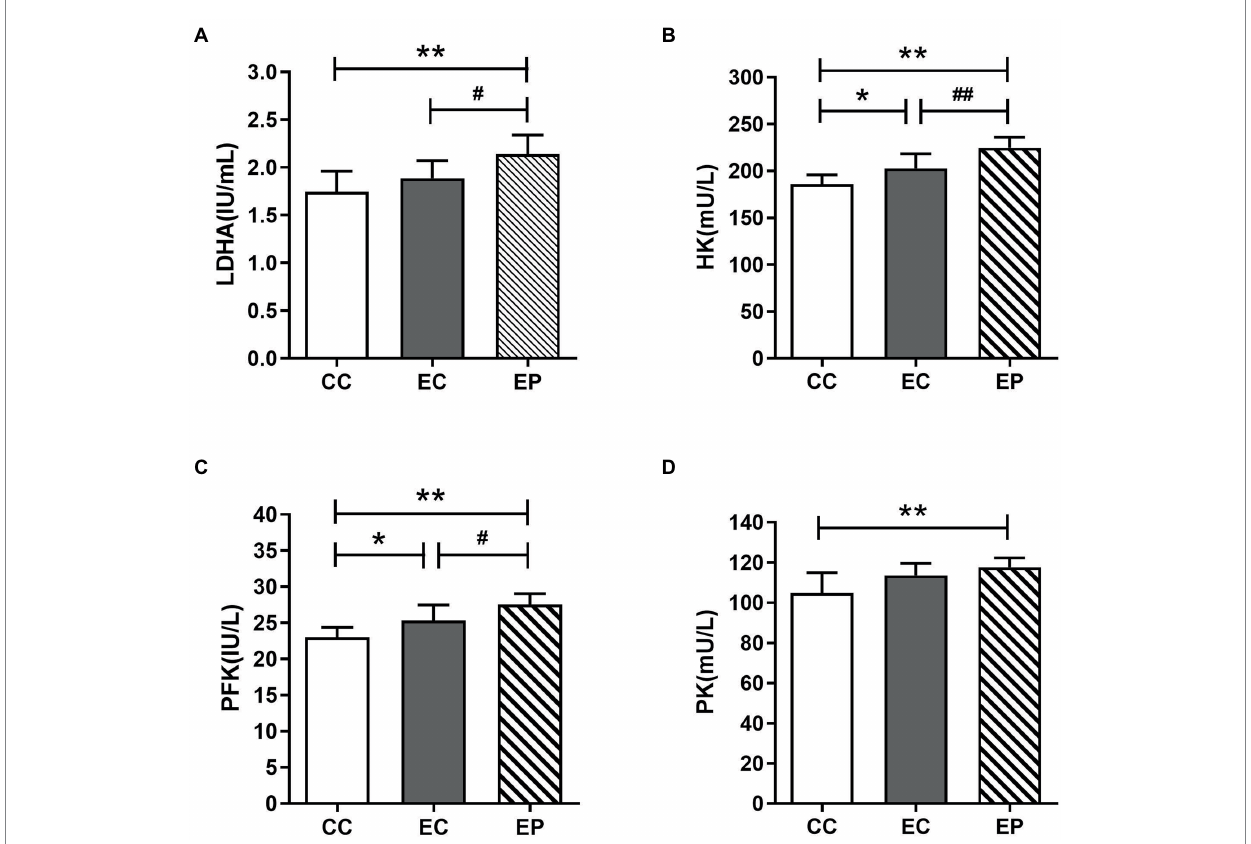
FIGURE 4 Effect of exogenous pyruvate pre-supplementation on glycolytic key enzymes activity in high-intensity interval exercise rats. (A) Lactate dehydrogenase A (LDHA) concentration. (B) Hexokinase (HK) concentration. (C) Phosphofructokinase (PFK) concentration. (D) Pyruvate kinase (PK) concentration.*Significantly different to control non-exercise (CC) group ( p < 0.05). **Significantly different to control non-exercise (CC) group ( p < 0.01). # Significantly different to control HIIE (EC) group ( p < 0.05). ## Significantly different to control HIIE (EC) group ( p <